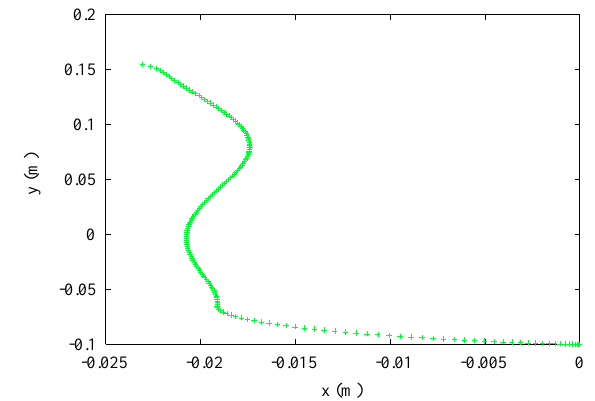
FIG. 9. (Color) An example of an orbit through a (cid:76) (cid:173) l (cid:121) (cid:50) coupler with (cid:82) (cid:99)(cid:111)(cid:117)(cid:112)(cid:108)(cid:101)(cid:114) (cid:44) (cid:50) (cid:82) (cid:98)(cid:101)(cid:110)(cid:100) , showing some mismatch. In this case the coil radius was 0.15 m and the particle exited the solenoid. Some mismatch is seen in the subsequent motion of the orbit after the coupler due to fringe fields from the straight and coupling sections.